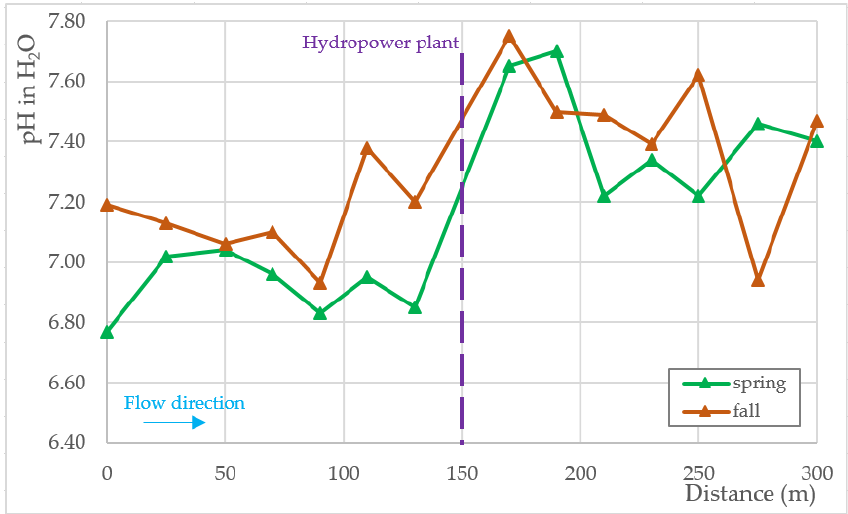
Figure 11. Changes in pH in H 2 O values in sediments in spring and fall near the hydropower plant on the Ślęza River, along with the geochemical classification.